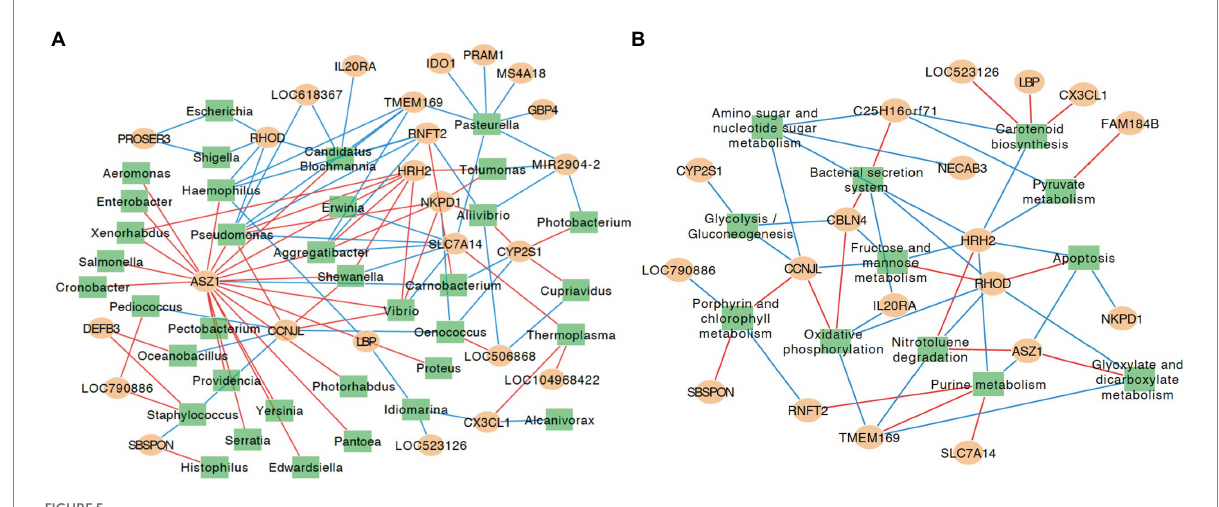
FIGURE 5 Correlation networks for identified differentially expressed genes, microbial taxa and microbial functions at KEGG pathway hierarchical level 3. (A) Correlation networks for identified differentially expressed genes and microbial taxa. (B) Correlation networks for identified differentially expressed genes and microbial functions at KEGG pathway hierarchical level 3. The yellow circles represent genes differentially expressed between groups A and B, and green rectangle represent the microbial taxa that were significantly different between groups A and B. The red lines indicate positive correlation, and blue lines indicate negative correlation; only correlations with rho values ≥ 0.8 and p ≤ 0.01 are shown. Data for genes/microbial taxa and functions that did not show a significant correlation are not